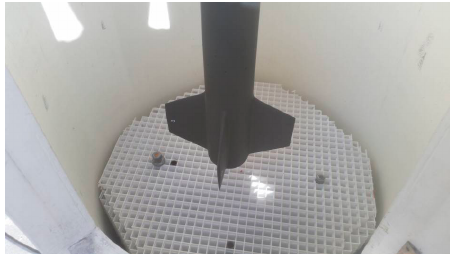
Figure 13. Egg crate used as a flow straightener to reduce swirl.